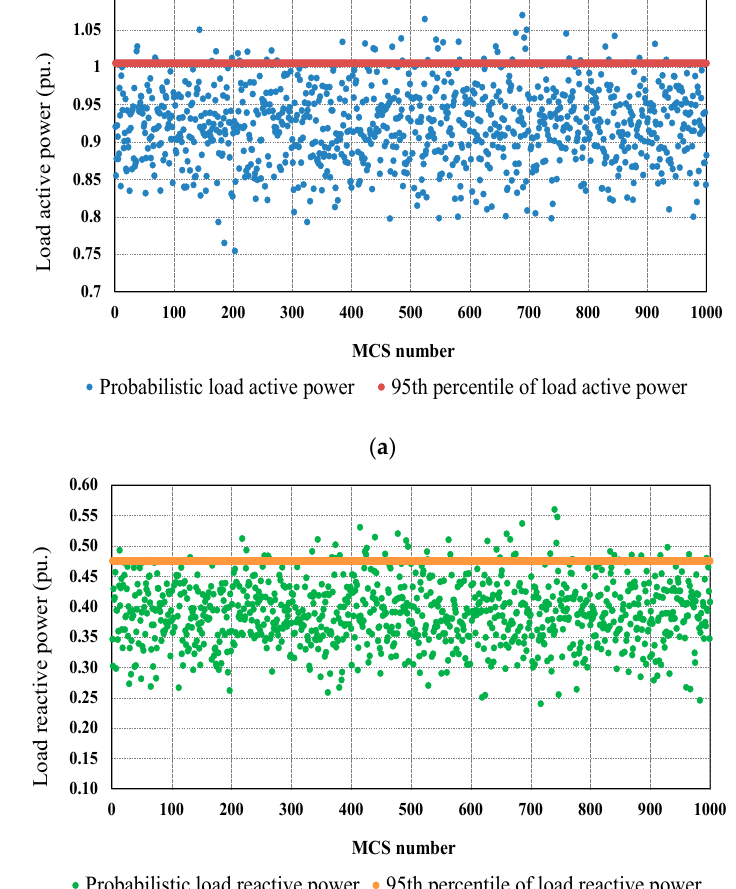
Figure 6. Probabilistic load parameters and their corresponding 95th percentiles: ( a ) Active power demand, ( b ) reactive power demand.